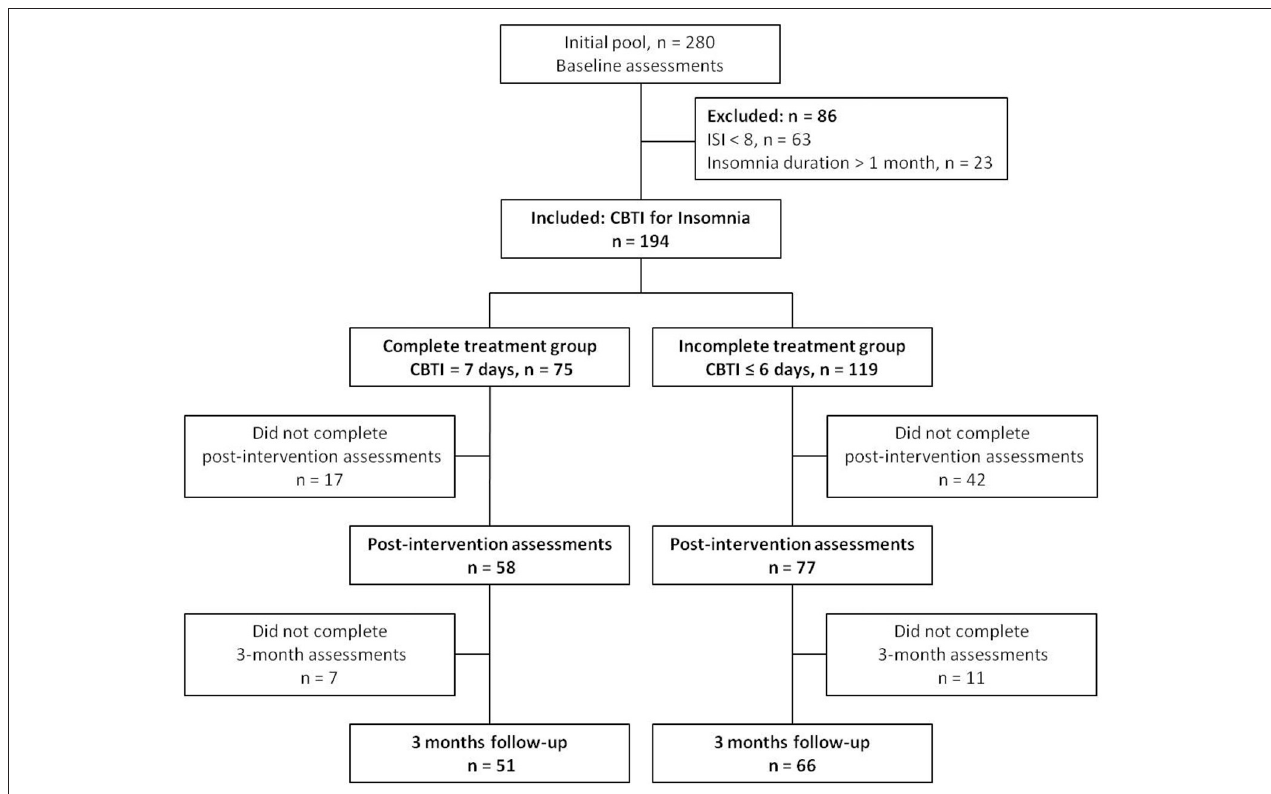
FIGURE 1 | Flow chart of the